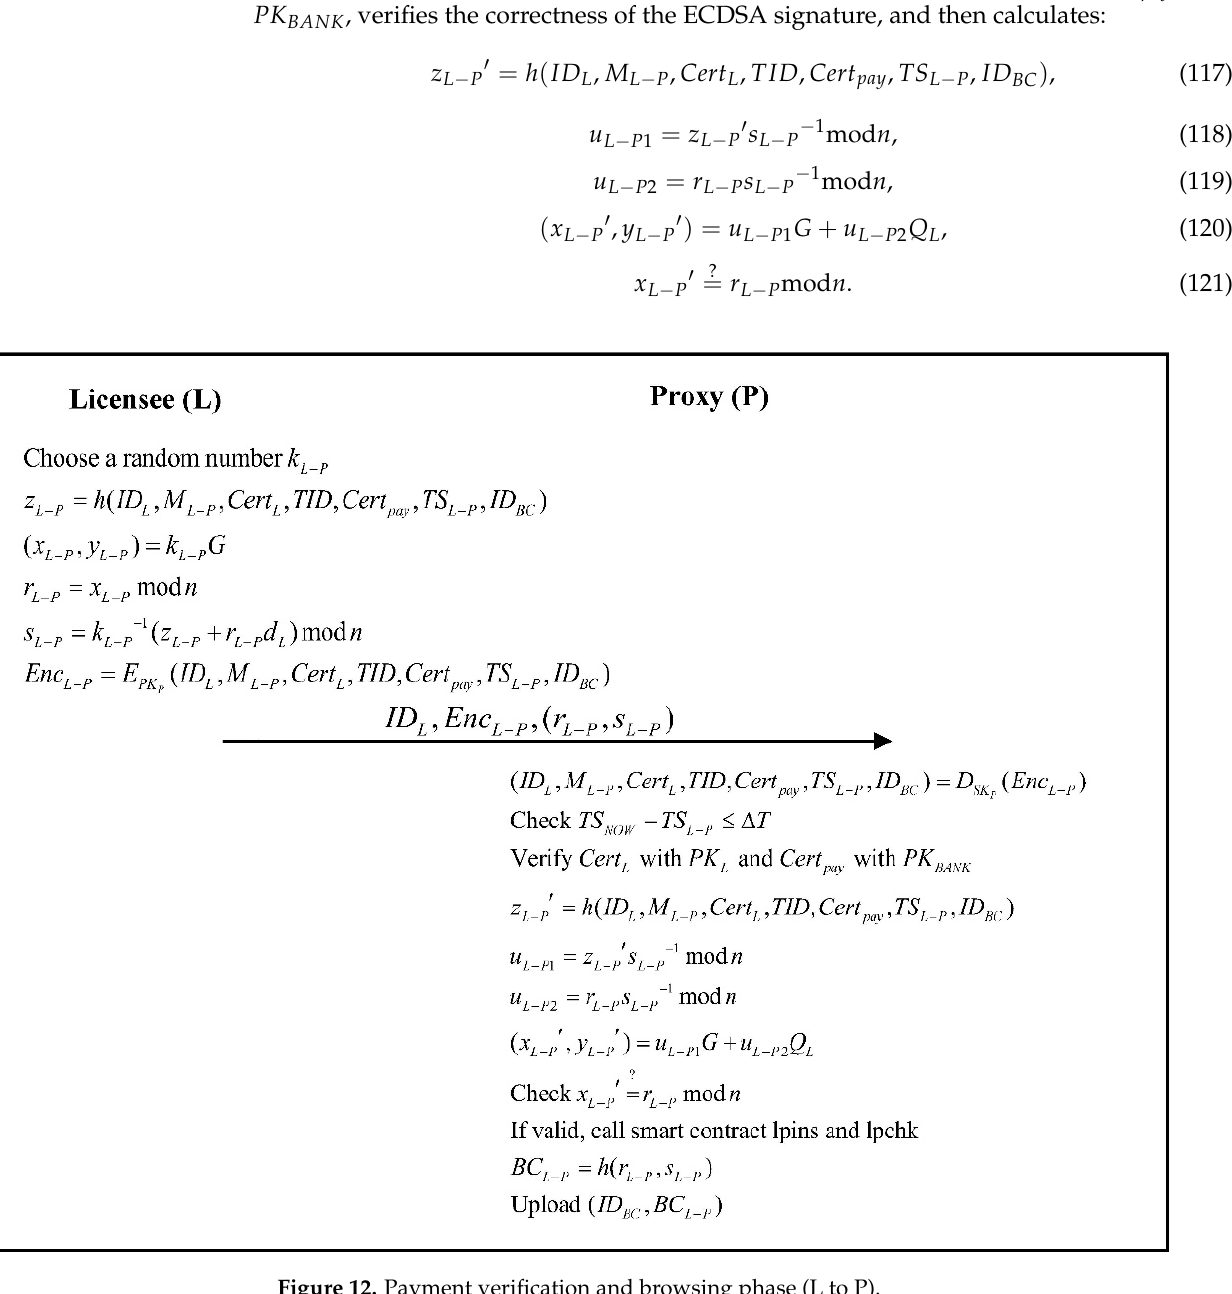
Figure 12. Payment verification and browsing phase (L to P).